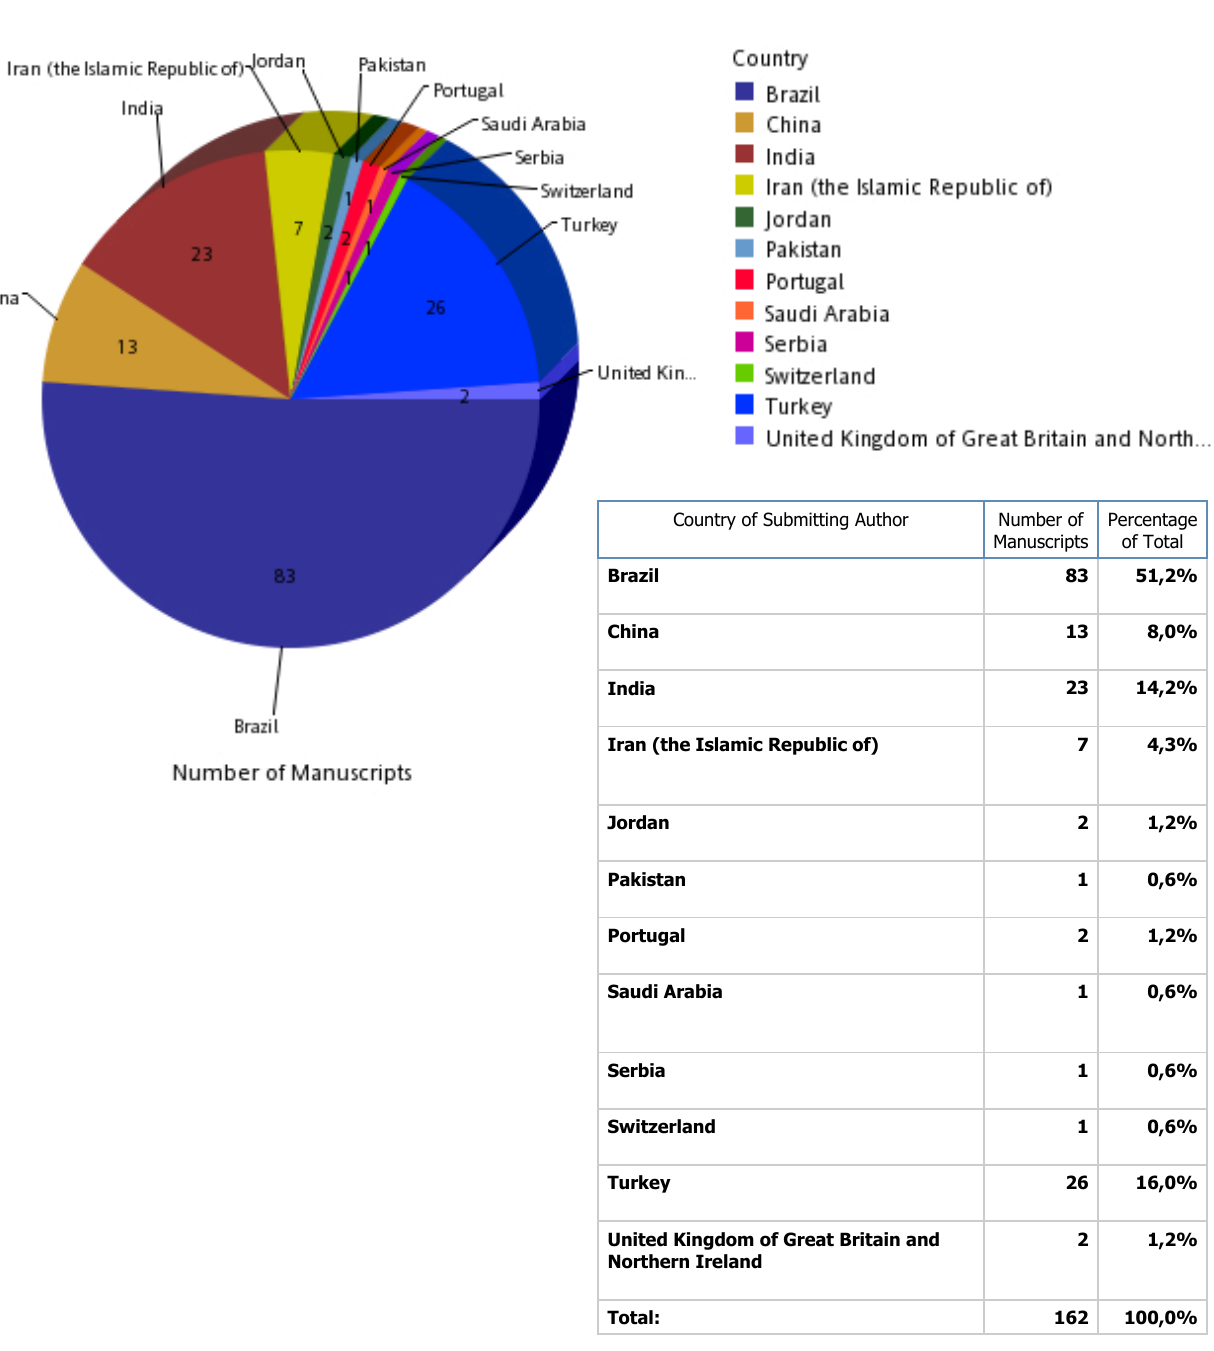
Fig. 1 - Countries that submitted manuscripts to the BJCVS between January 1 and May